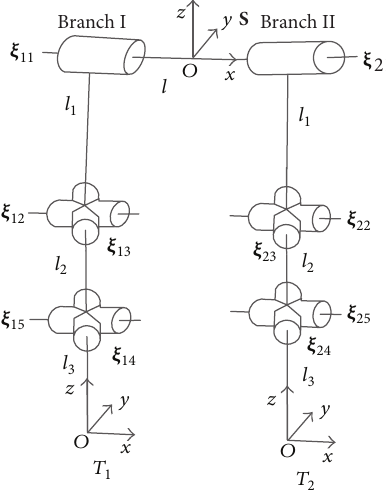
Figure 2: The mechanism of foot in swing phase (reference config- uration).